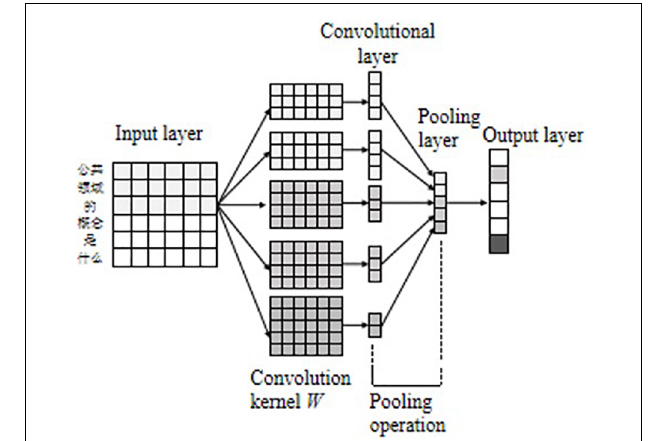
FIGURE 4 | CNN model